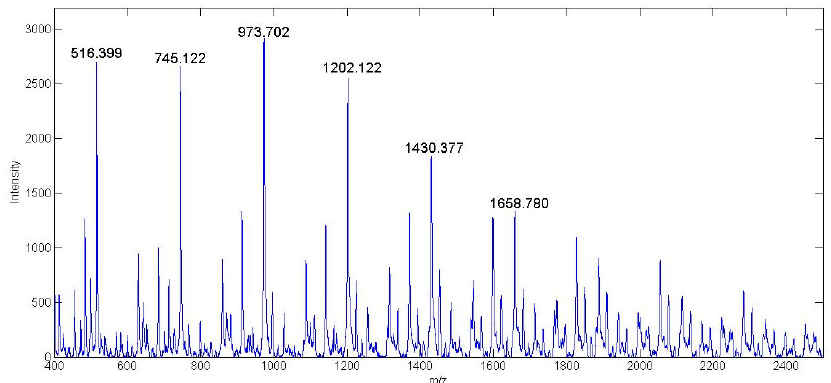
Figure 6. MALDI-TOF analysis of G1 HPAMAM.